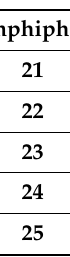
Table 1. CAC of amphiphiles determined using surface tension